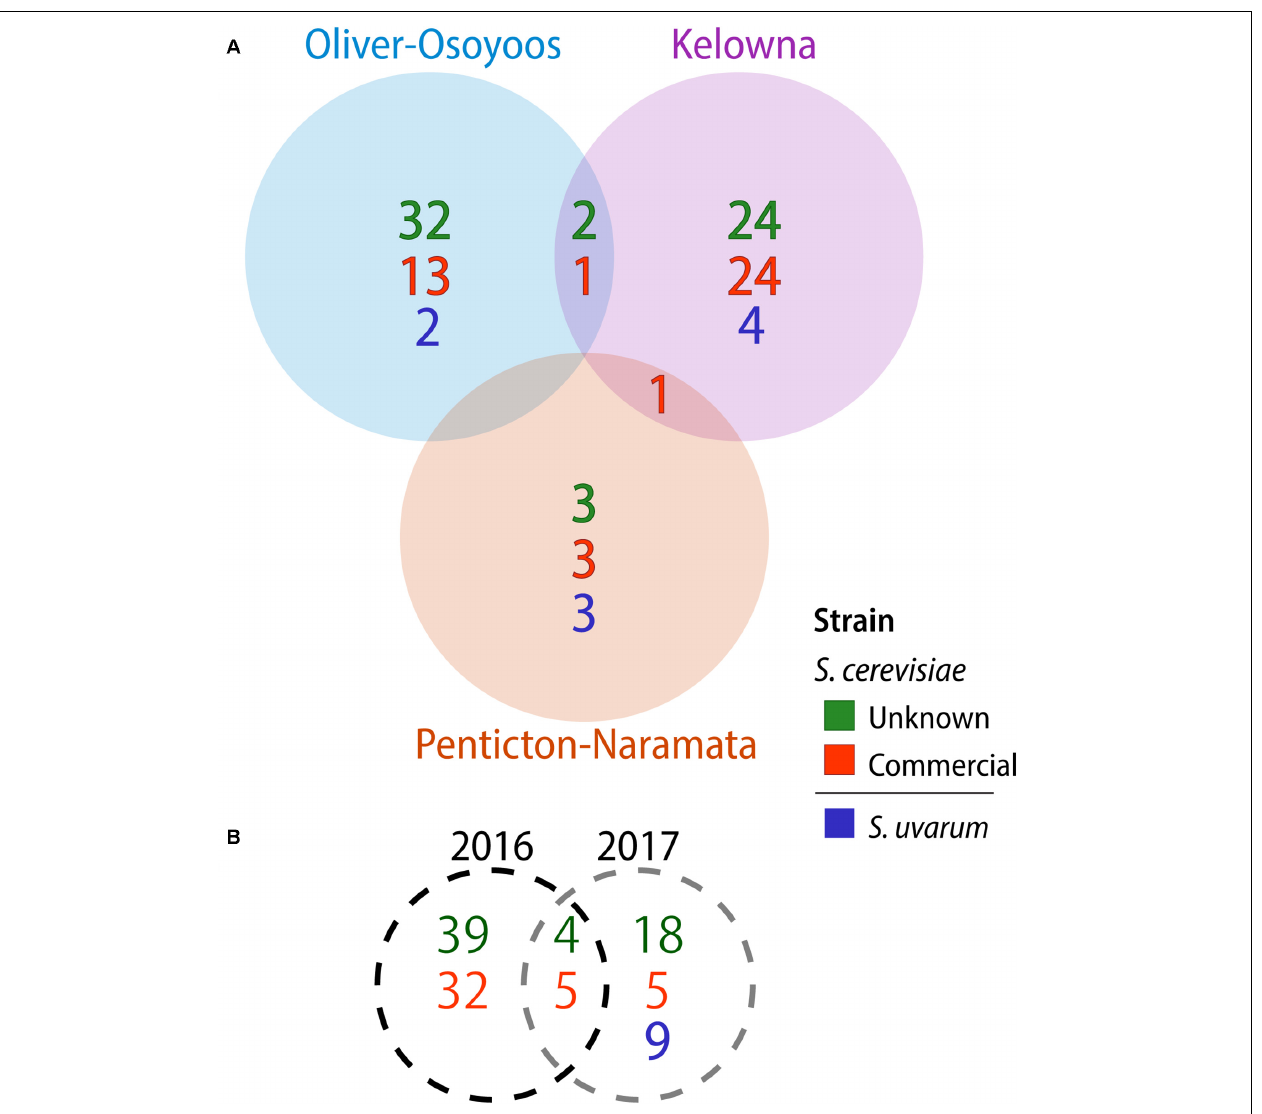
FIGURE 2 | Saccharomyces cerevisiae and S. uvarum strains isolated by (A) OV sub-region and (B) vintage. Commercial S. cerevisiae strains are in red, unknown strains in green, while S. uvarum strains are